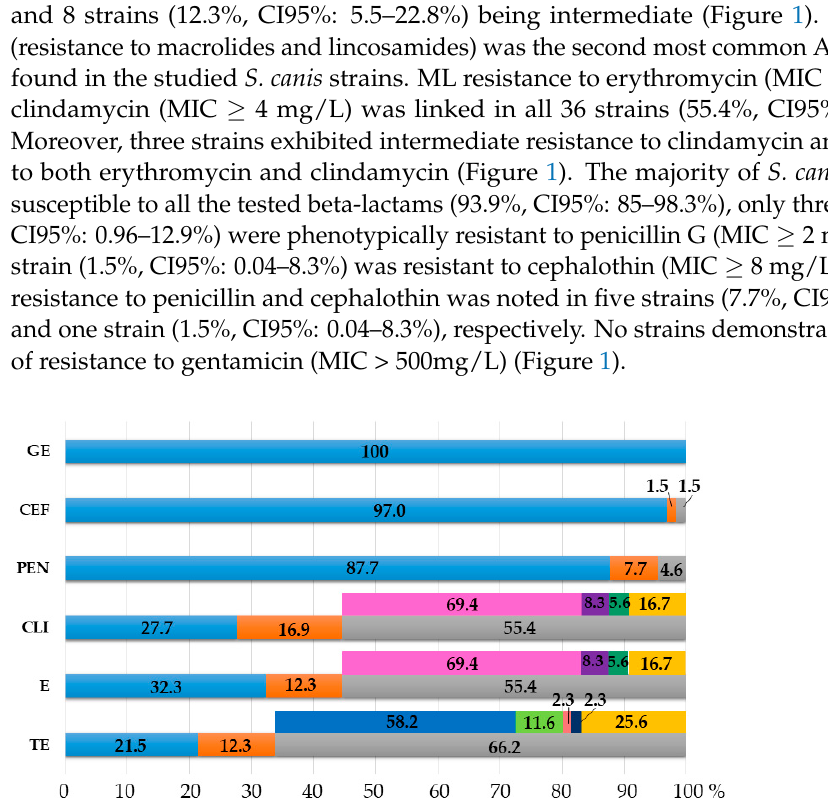
* Antimicrobial agents used in this study: penicillin G (PEN), cephalothin (CEF), gentamicin (GE), tetracycline (TE), erythromycin (E) and clindamycin (CLI). Light-grey shading indicates strains displaying an intermediate